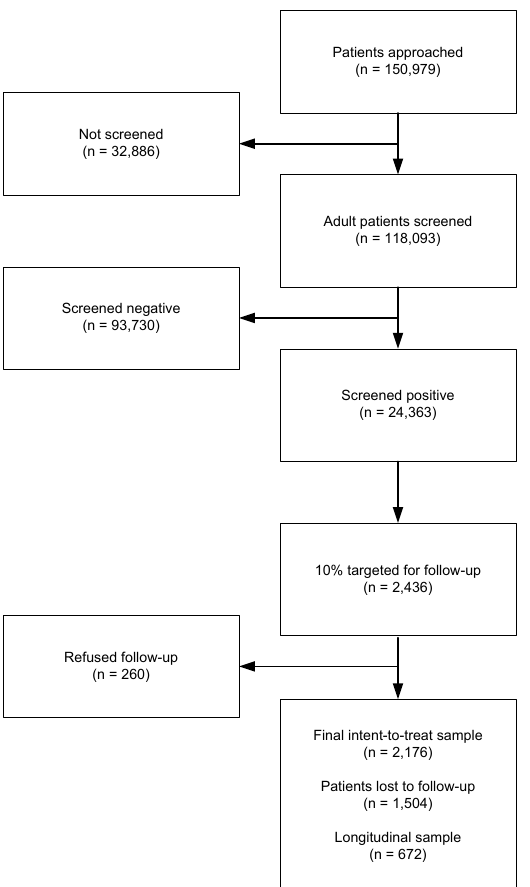
Figure 1. Chart showing formation of study